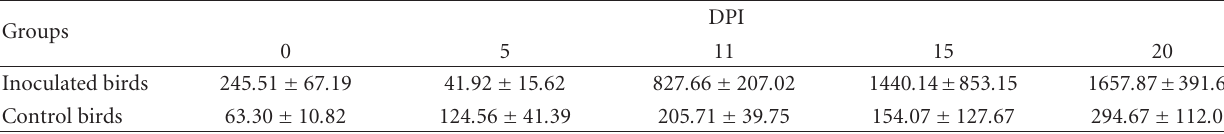
Table 3: Comparisons of infectious bronchitis antibodies titers (ELISA) in infected and control group (mean ± SE). Groups